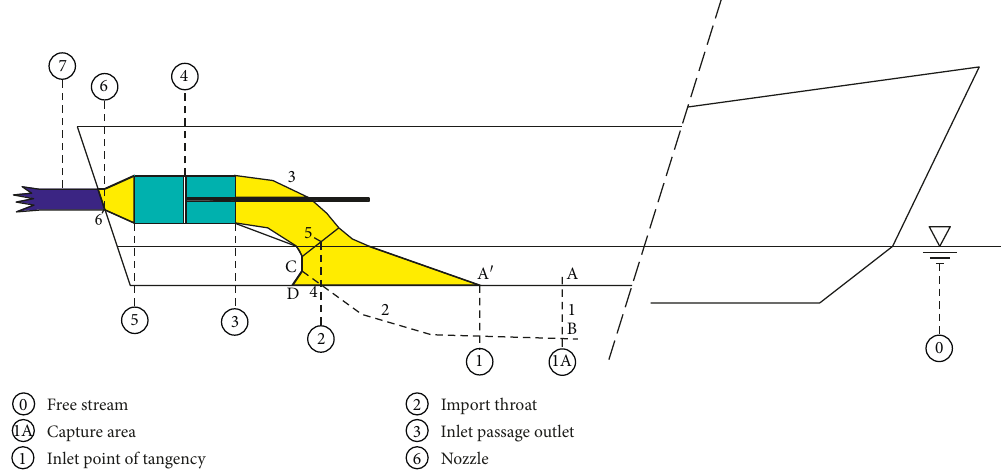
Figure 8: 24th ITTC definitions of standard locations of the waterjet propulsion system. Table 3: Calculation parameters of inlet